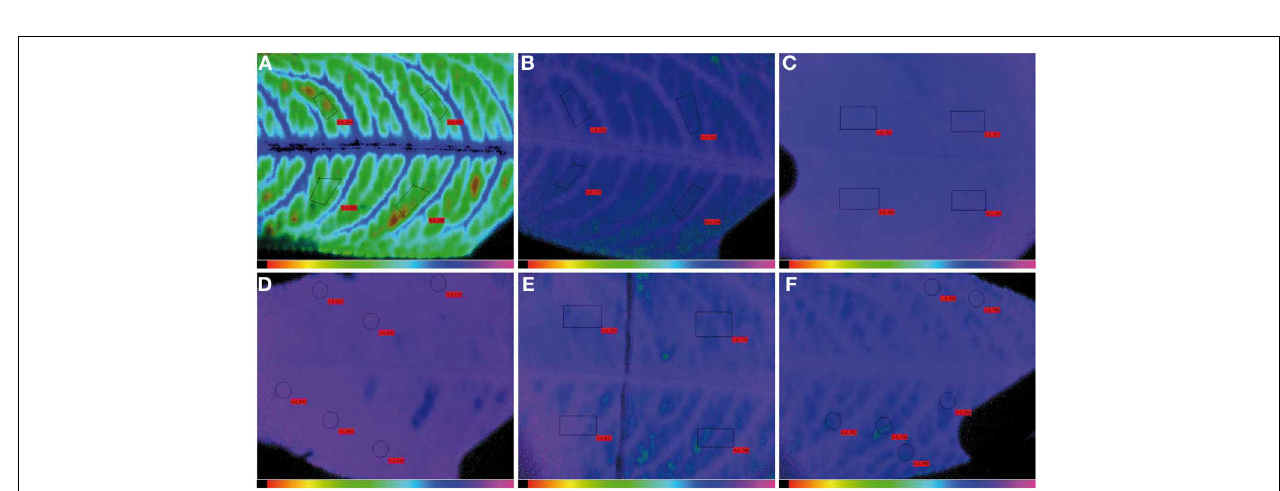
FIGURE 8 | Peach tree leaves used for the Chl fluorescence measurements. (A) Severely chlorotic leaf, with a very advanced chlorosis, taken from the distal part of the shoot; (B) Fe-deficient leaf taken at the 4 th –5 th position in the shoot, one week after treatment by dipping the distal half of the leaf in a solution containing 2mM FeSO 4